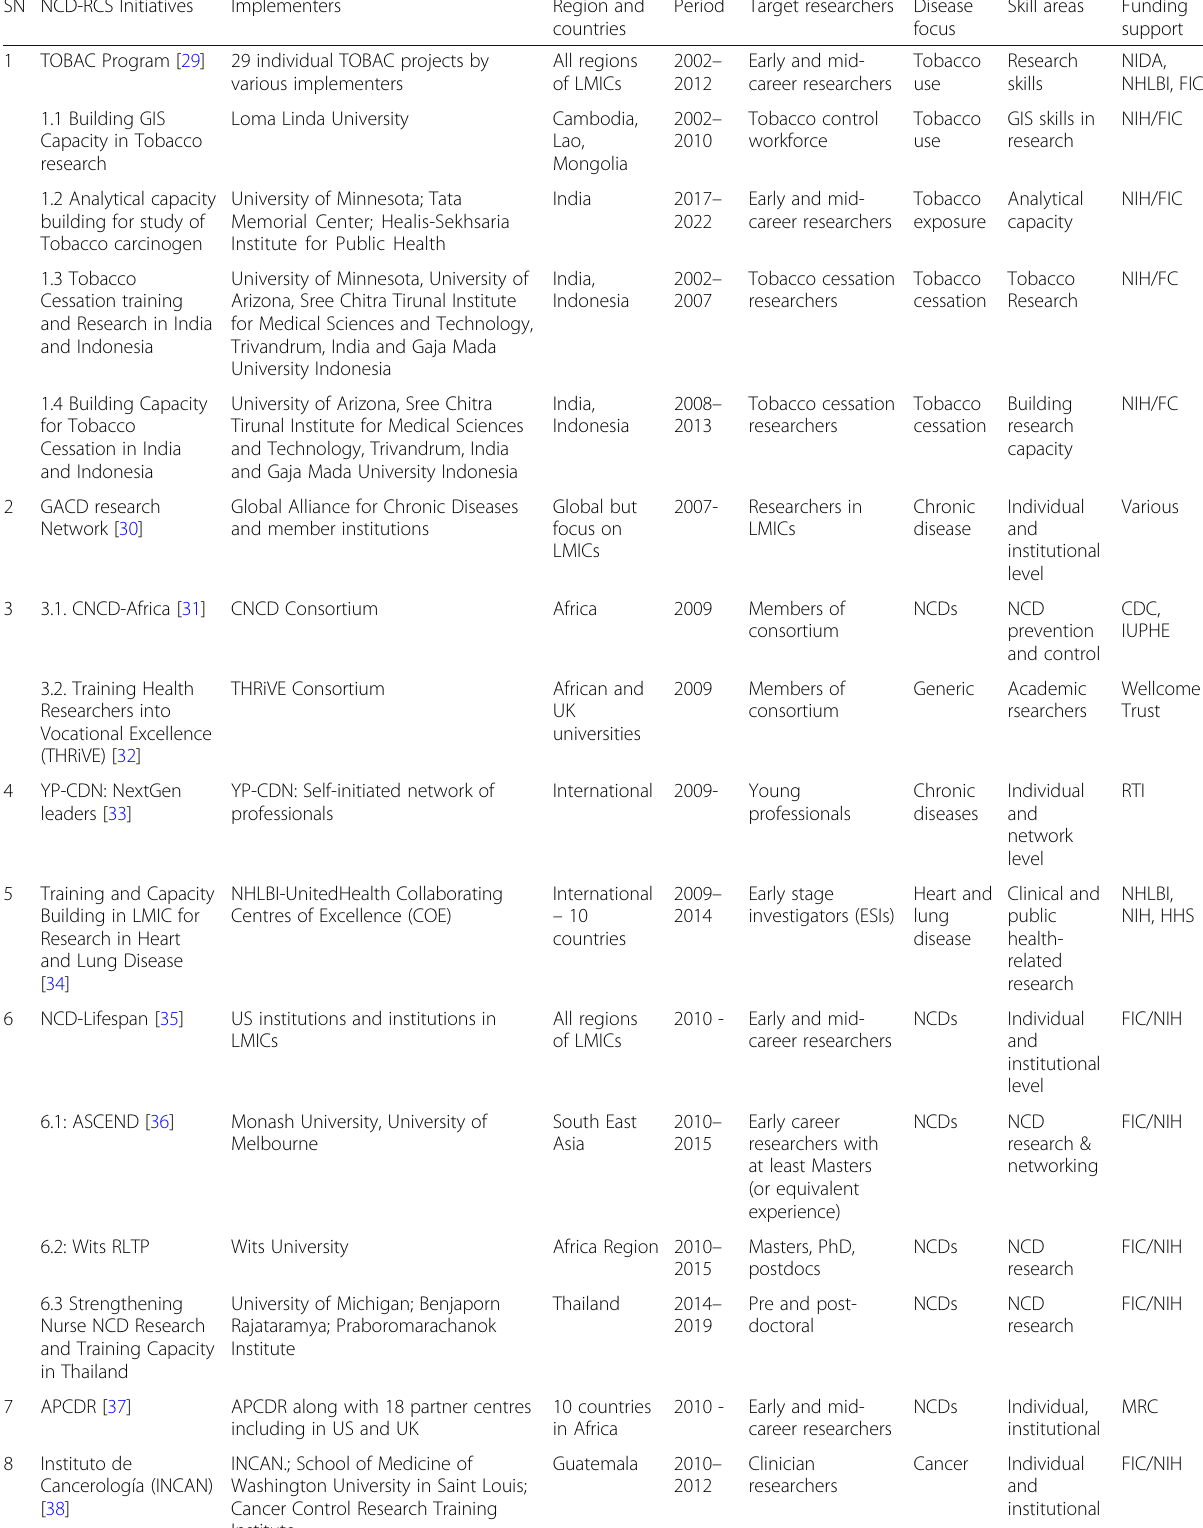
Table 1 Characteristics of NCD-RCS initiatives included in this